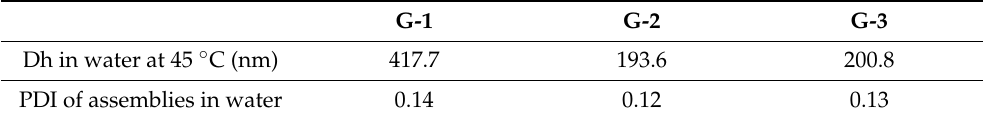
Figure 5. ( a ) DLS results of G-1 (red line), G-2 (black line) and G-3 (blue line) self-assembled in water at 45 °C. SEM images of self-assemblies of G-1 ( b ), G-2 ( c ) and G-3 ( d ). The scale bar in 5b and 5c is 1 μm and the scale bar in 5d is 800 nm. Table 5. Structure data of the lysozyme modified bioconjugates and DLS results of their self-assemblies. G-1 Dh in water at 45 ◦ C